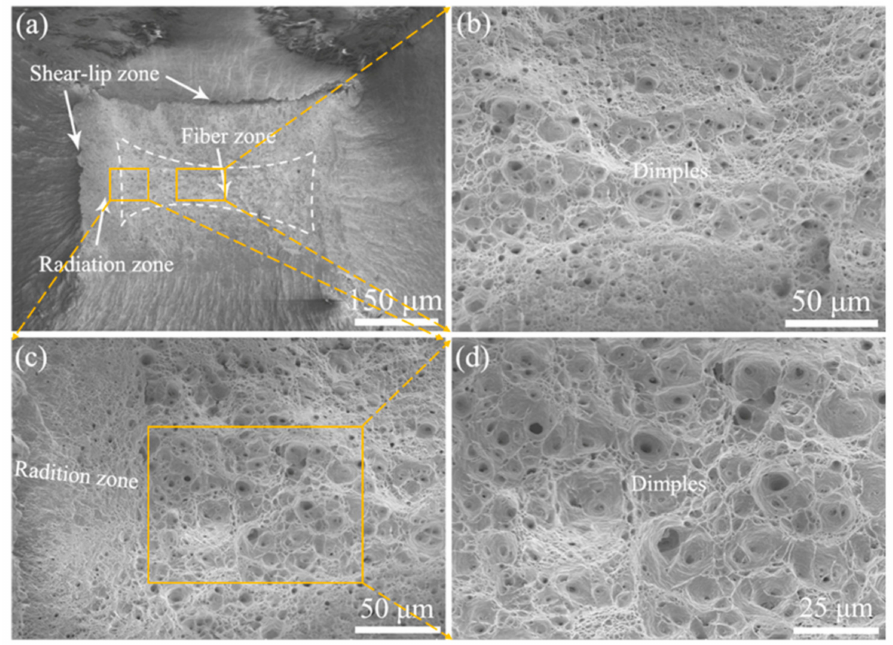
Figure 11. Fracture morphology of 9Cr-F/M steel at 550 ◦ C: ( a ) macro view presenting rectangular necking features, ( b ) magnified image of the fiber zone, ( c ) magnified view of the selected radiation zone, and ( d ) magnified image from the middle of ( c